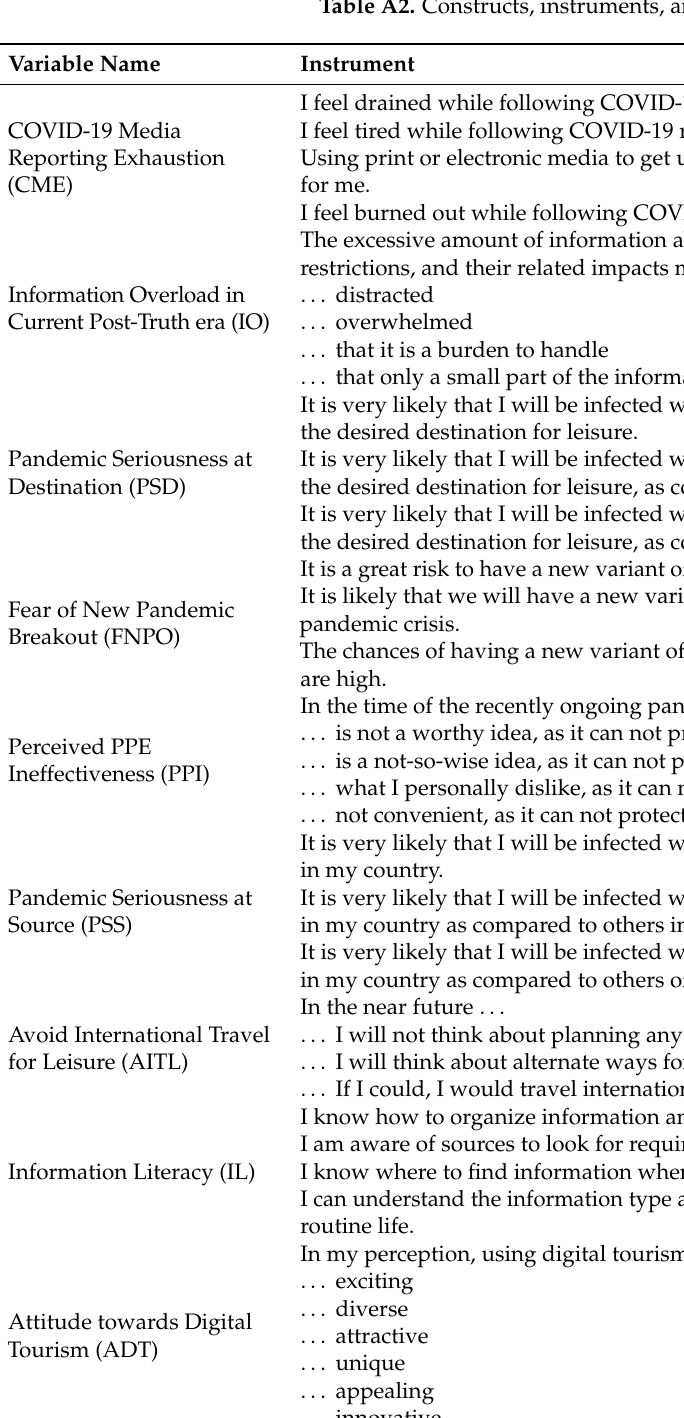
Table A2. Constructs, instruments, and adapted